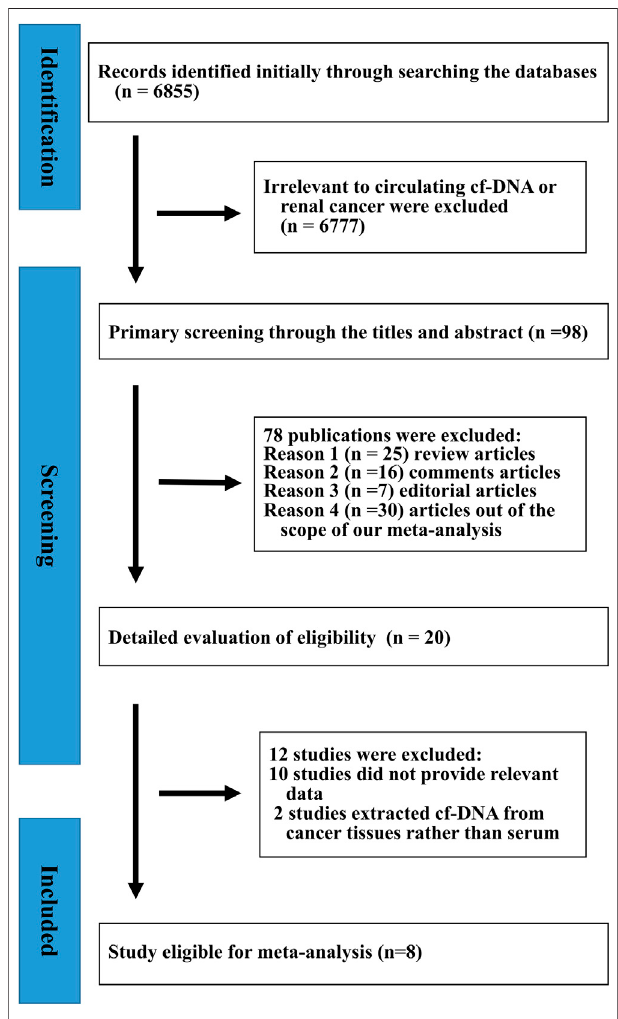
FIGURE 1 | Flowchart describing the selection of publications for meta-